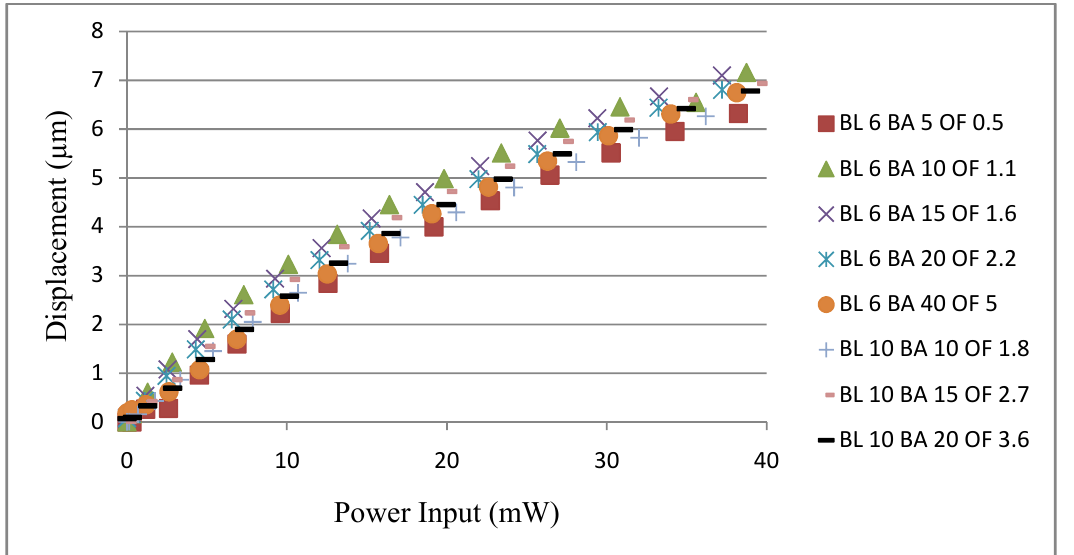
Figure 5. Experimental displacement vs . applied voltage graph of kink actuators with an arm length of 150